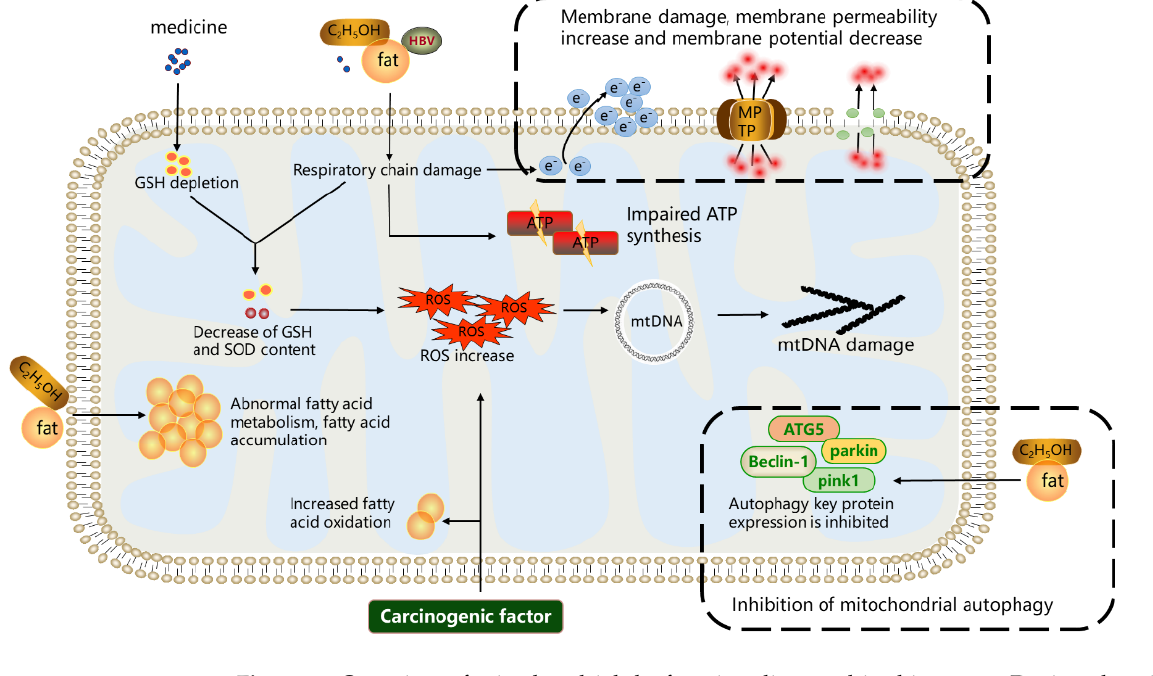
Figure 1. Overview of mitochondrial dysfunction discussed in this paper. During chronic liver disease, various factors can lead to classical changes, including the morphological structure, increased ROS, damaged mtDNA, abnormal energy metabolism, and autophagy within mitochondria.